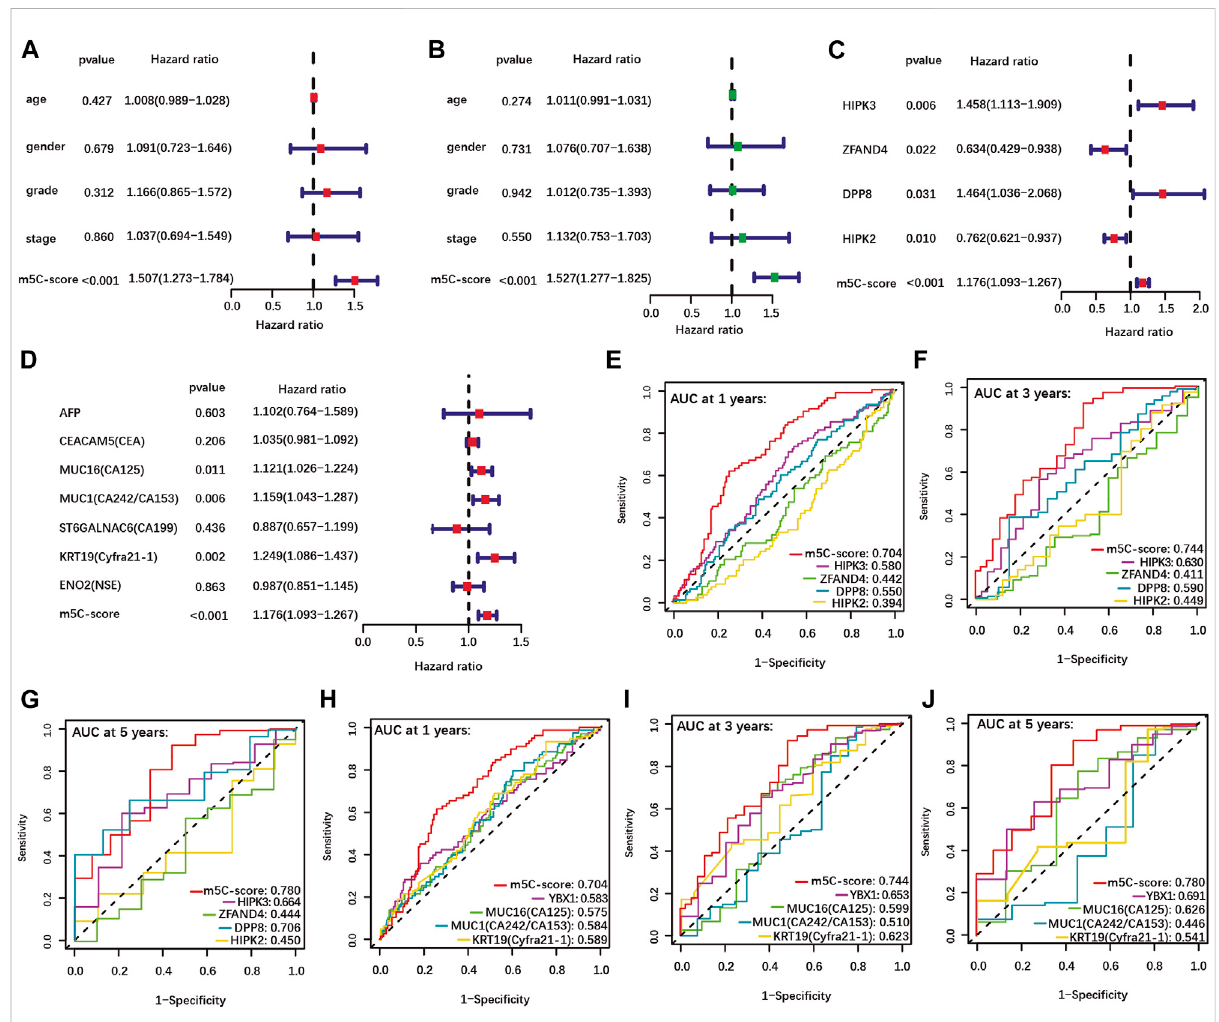
FIGURE 4 Higher predictive value of the m5C-score compared with clinical factors, individual m5C-regulator genes and tumor marker genes. (A – B) Univariate (A) and multivariate (B) Cox regression analyses of OS of m5C-score and clinical factors from the TCGA-PAAD cohort. (C – D) Univariate Cox regression analyses of OS of m5C-score and individual m5C-score genes (C) and tumor marker genes (D) in the TCGA-PAAD and GSE57495 cohorts. (E – J) The AUC of ROC curves shows the predictive value of OS at 1, 3 and 5 years of m5C-score compared to individual m5C-score genes (E – G) , or the prognostic-related m5C-regulator YBX1 and serum tumor marker genes (H – J)